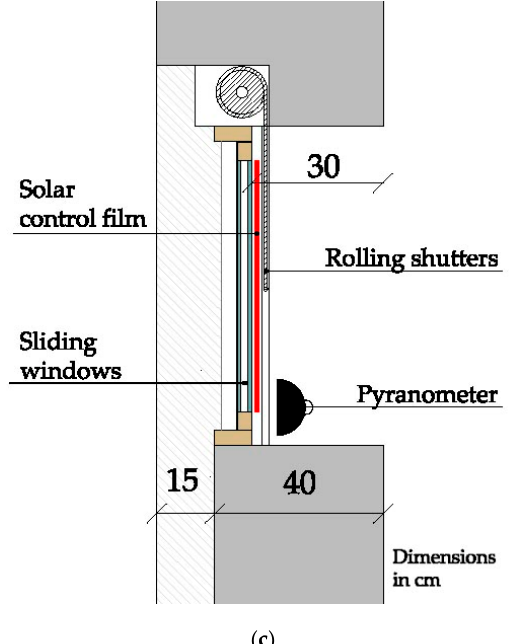
Figure 3. ( a ) Sliding windows with the shading roller shutters in the monitored room; ( b ) Solar control film; ( c ) Cross section of the windows and location of pyranometer. Source: ( a , c ) Authors, ( b ) Manufacturer.